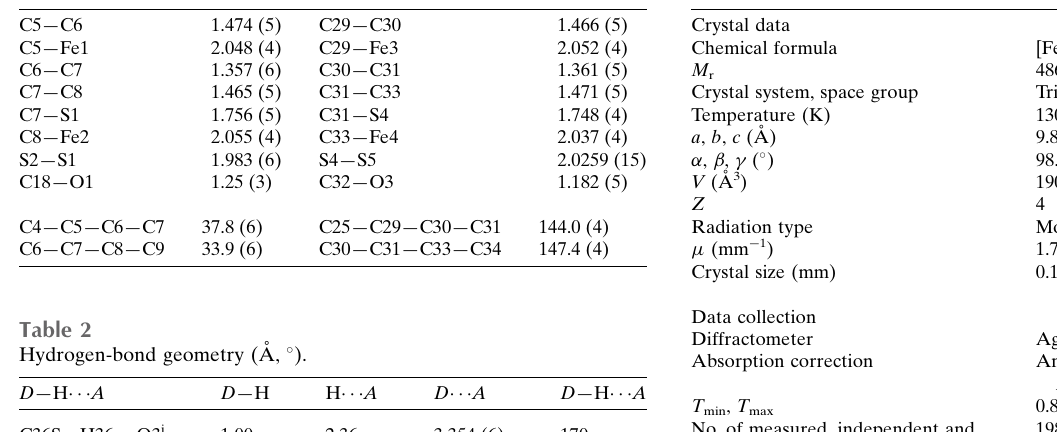
Table 1 Selected geometric parameters (A˚ , (cid:2) ).